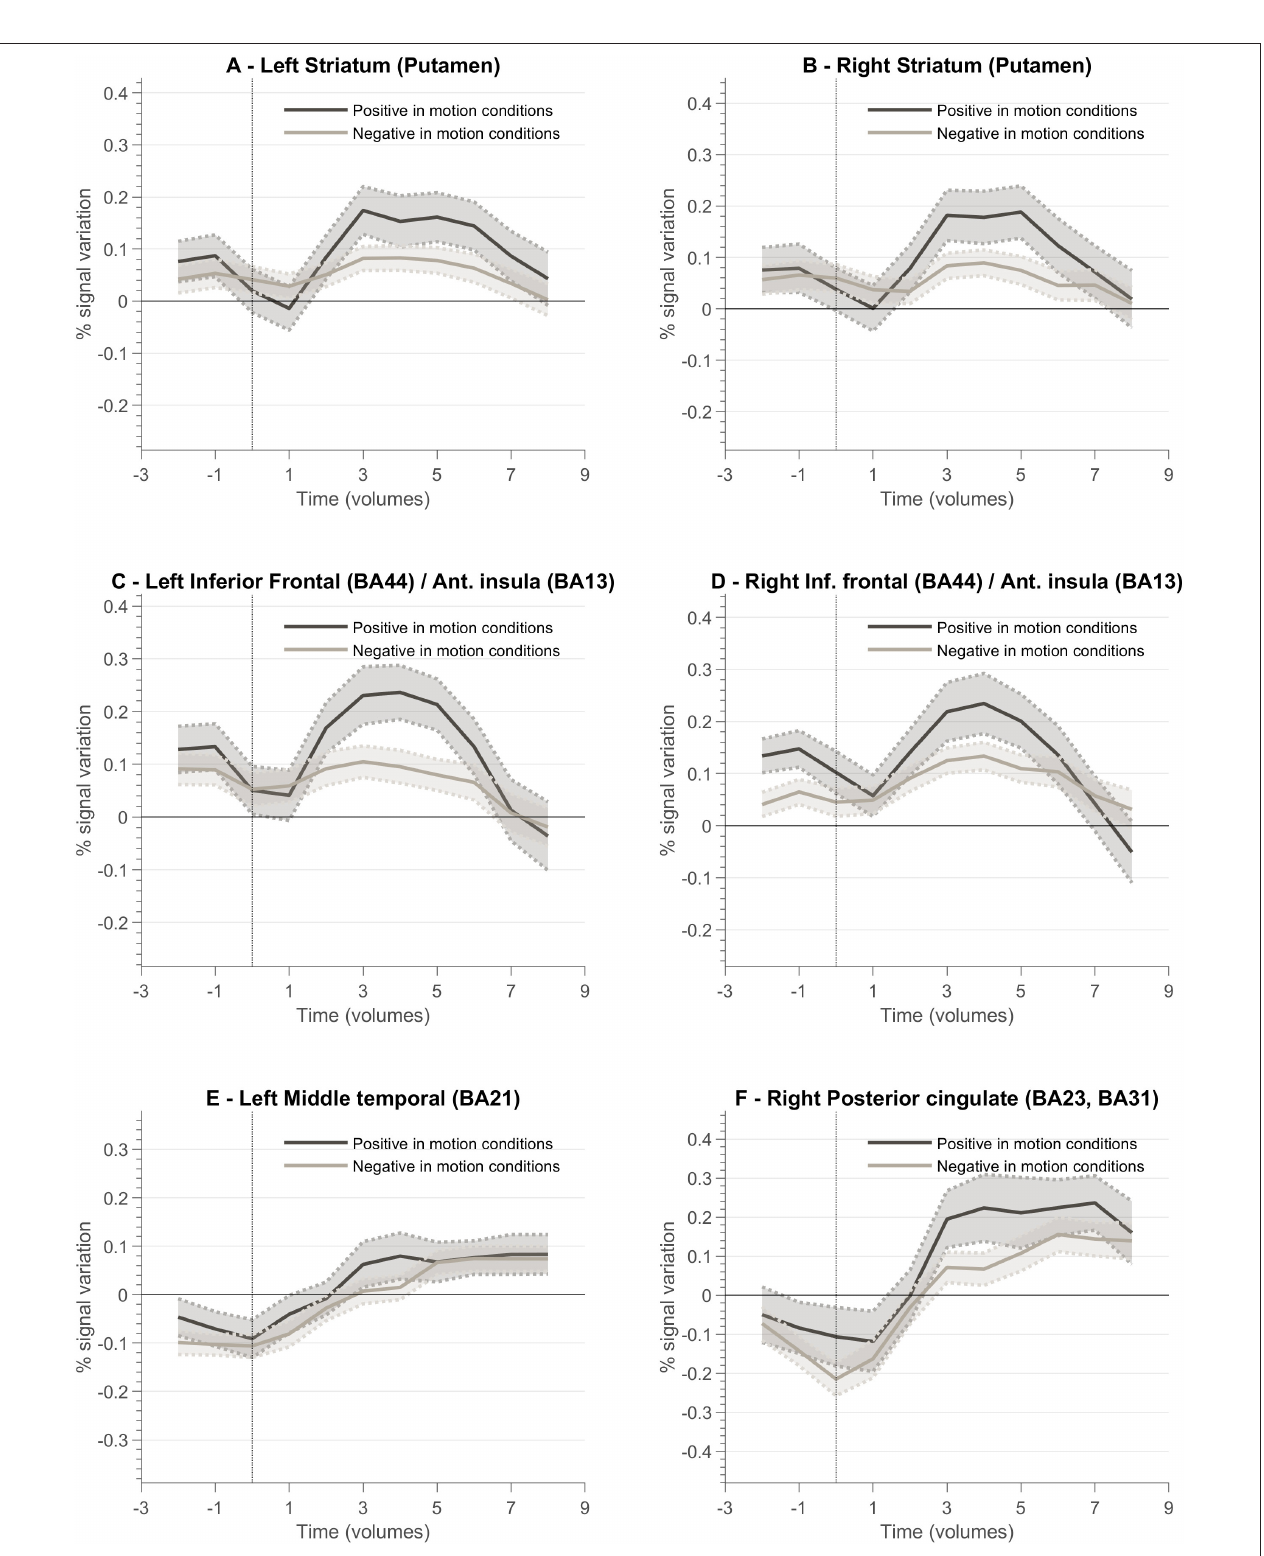
FIGURE 8 | Feedback valence—(positive and negative) event-related responses averaged across all participants (n = 10) for different ROIs involved in the neurofeedback task. Each plot presents the positive and negative feedback event-related curve for the following ROIs: (A) Left Striatum (Putamen); (B) Right Striatum (Putamen); (C) Left Inferior Frontal Cortex (Brodmann Area, BA, 44)/Anterior Insula (BA13); (D) Right Inferior Frontal Cortex (BA44)/Right Anterior Insula (BA13); (E) Left Middle Temporal Cortex (BA21); (F) Right Posterior Cingulate Cortex (BA23, BA31).